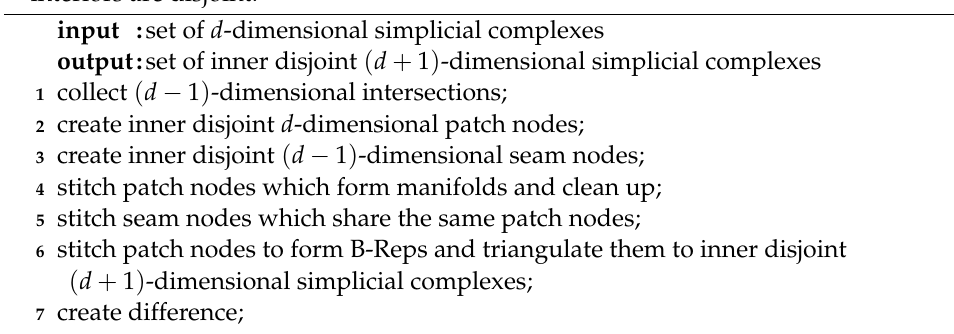
Algorithm 1: Computing a set of ( d + 1 ) -dimensional simplicial complexes from a set of d -dimensional simplicial complexes— inner disjoint means that the interiors are